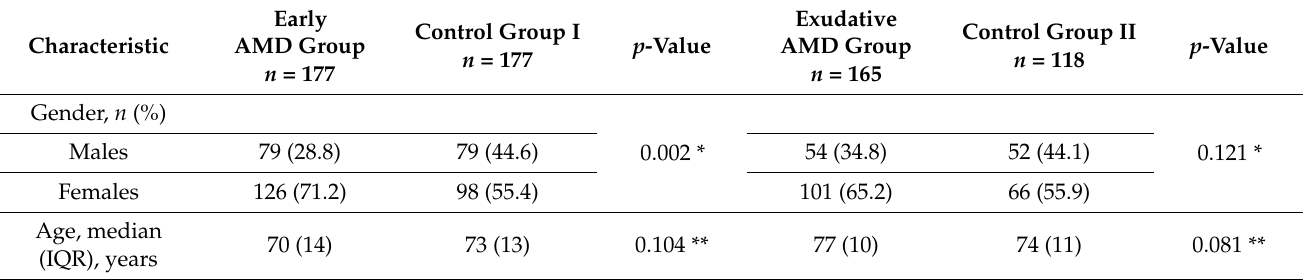
Table 1. Demographic characteristics of patients with early and exudative age-related macular degeneration (AMD) and control group